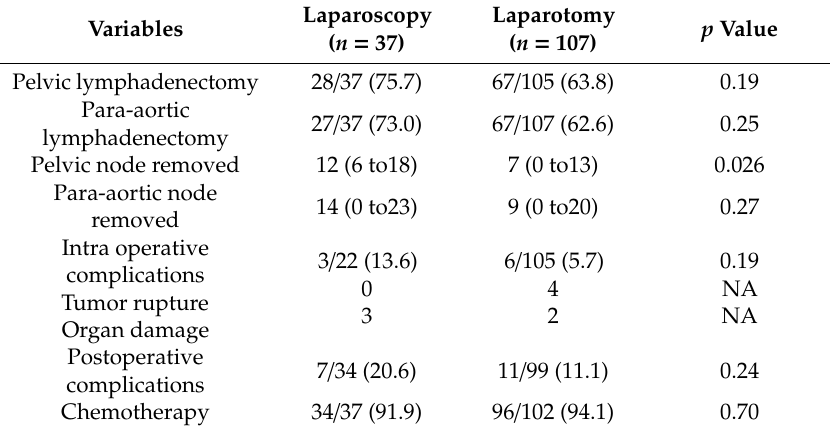
Table 2. Patients’